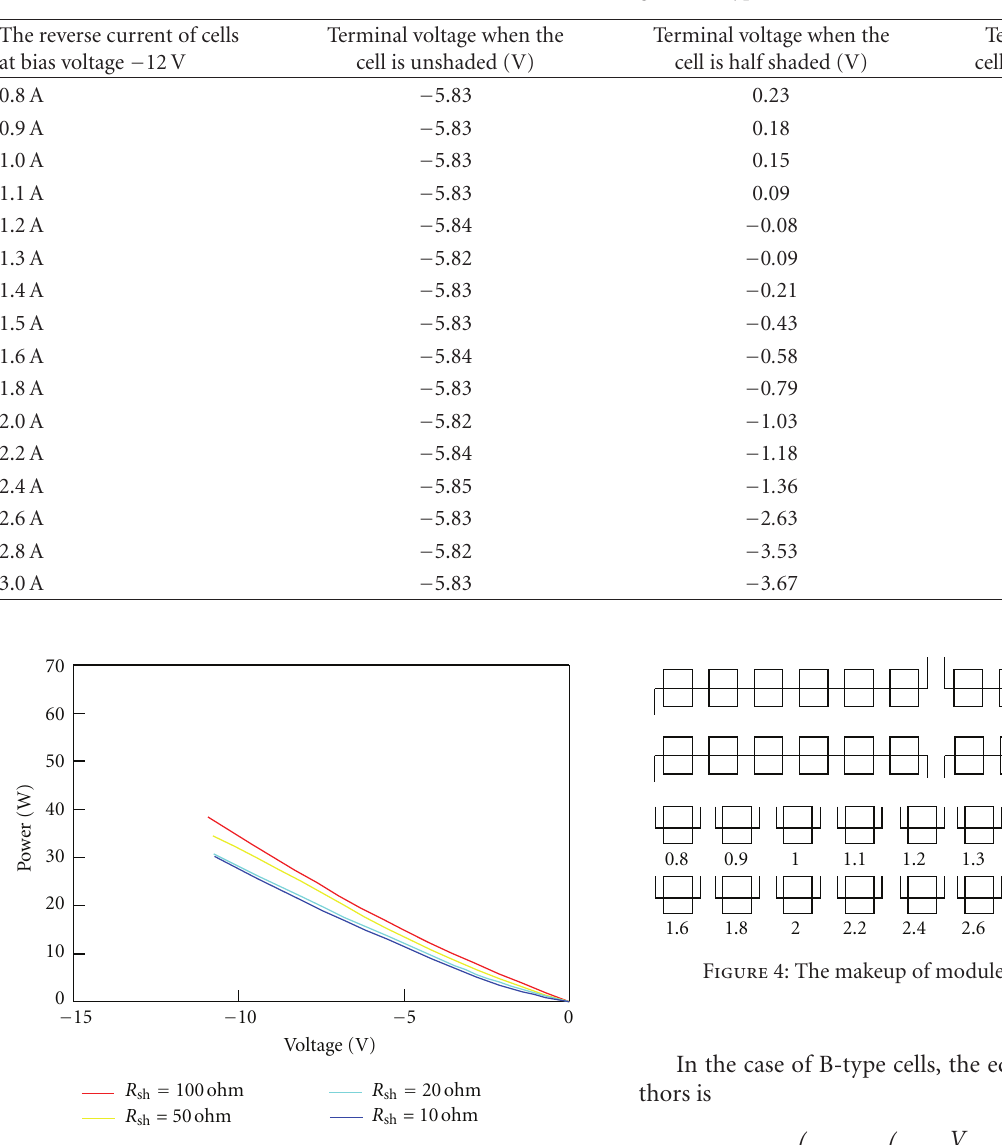
Figure 3: The dissipated power at di ff erent shunt resistance.